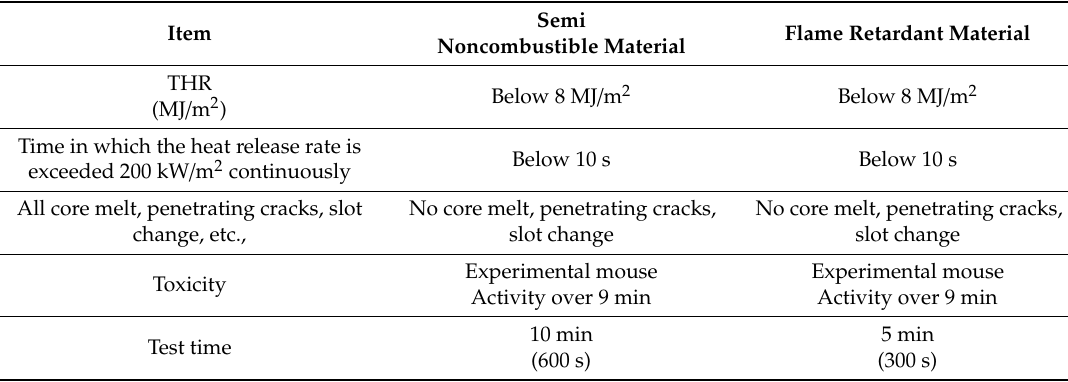
Figure 12. ( a ) Schematic of heat flow in cone calorimetry experiment and ( b ) image of expanded layer.